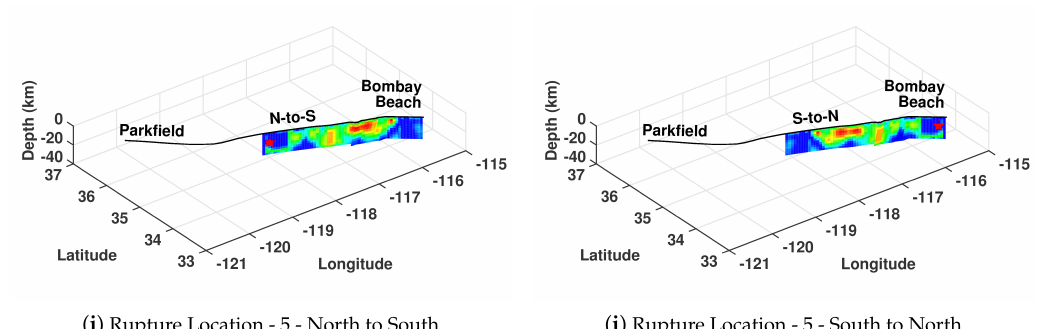
Figure 1. Kinematic finite source model of the 2002 M w 7.9 Denali earthquake mapped on the southern San Andreas fault at five locations. Blue areas represent regions of small slip and red areas represent regions of large slip (peak slip of about 12 m). The left column illustrates the five north-to-south propagating scenario earthquakes whereas the right column illustrates the south-to-north propagating earthquakes. Note that in reversing the rupture direction, the slip distribution is flipped as well. The red stars correspond to the